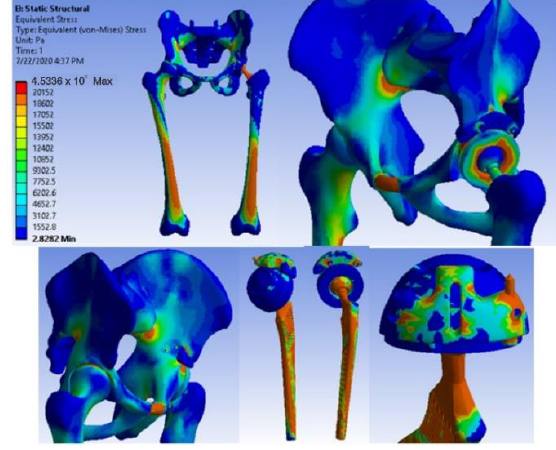
Figure 43. Stress maps for revision prosthesis with titanium augment.